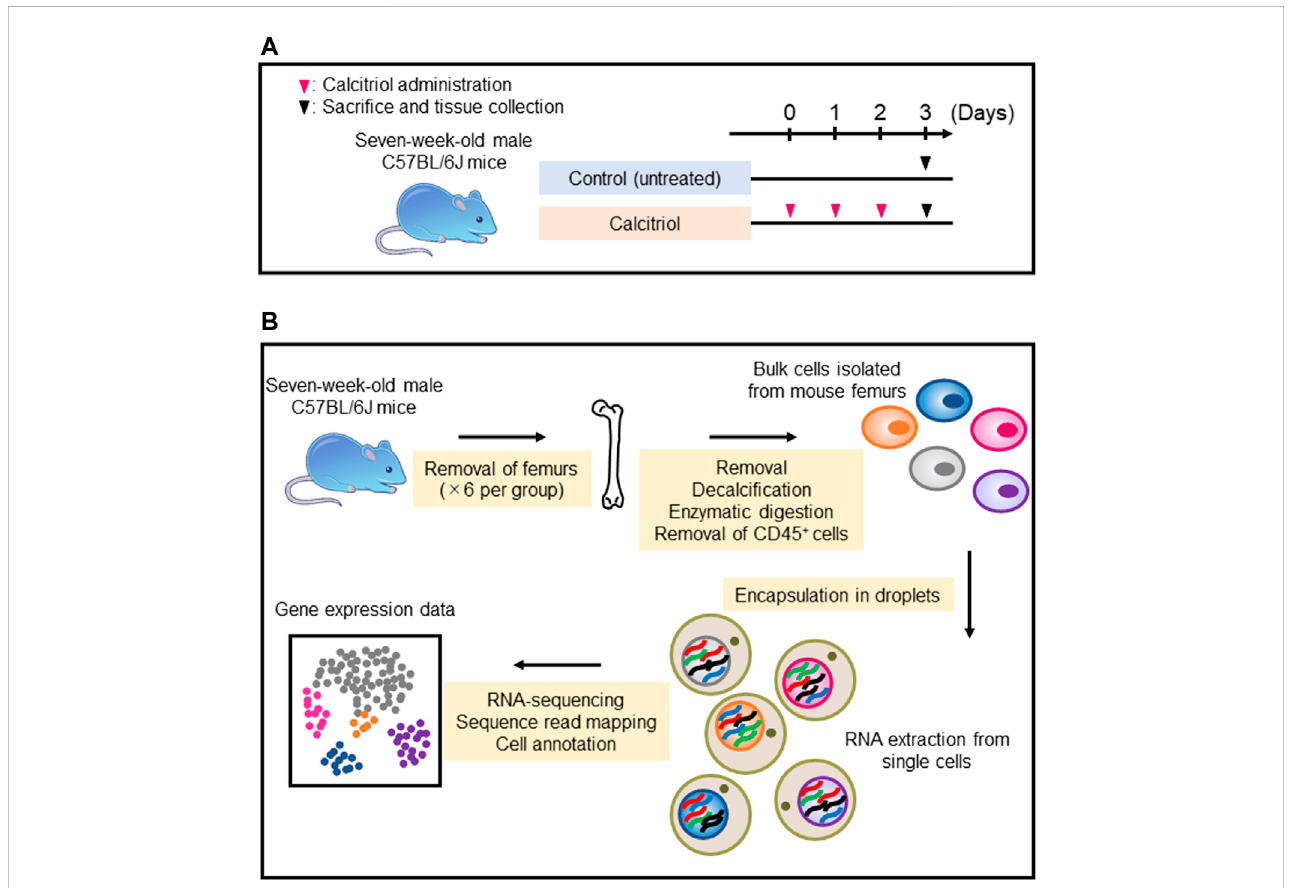
FIGURE 2 Single-cell RNA sequencing sample preparation and RNA sequencing protocol. (A) Seven-week-old male C57BL/6J mice were injected with 2.5 μ g per kg of calcitriol ( n = 6) every day for 3 days. As a control, six untreated C57BL/6J mice were sacri fi ced on day 3. (B) Each cell isolated from six femurs by collagenase digestion and EGTA treatment was encapsulated in a droplet for mRNA extraction and RNA sequencing.